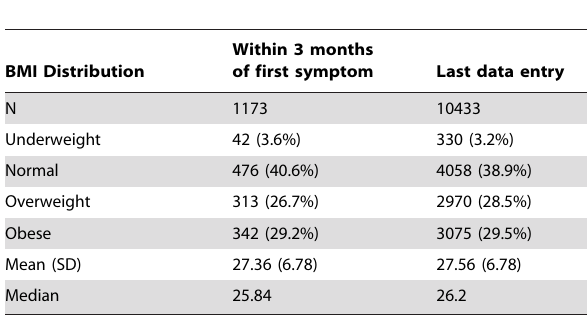
Table 3. Distribution of self-reported BMI in the PLM